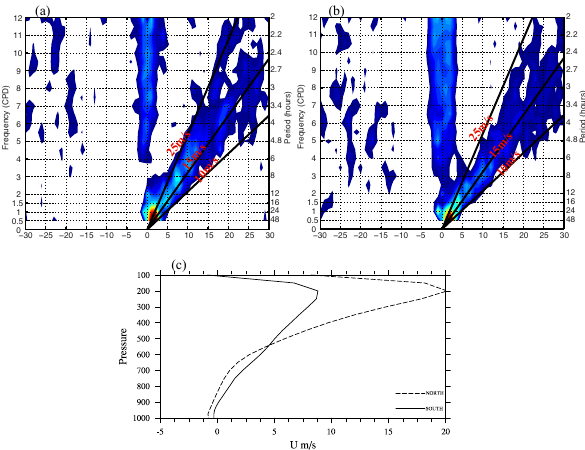
Figure 14. Top: similar to Fig. 9 but calculated over (a) north of 30 ◦ N and (b) south of 30 ◦ N for the focus domain in East Asia. (c) Vertical profile of areal mean zonal wind speed averaged over the northern and southern part of the focus domain in East Asia.